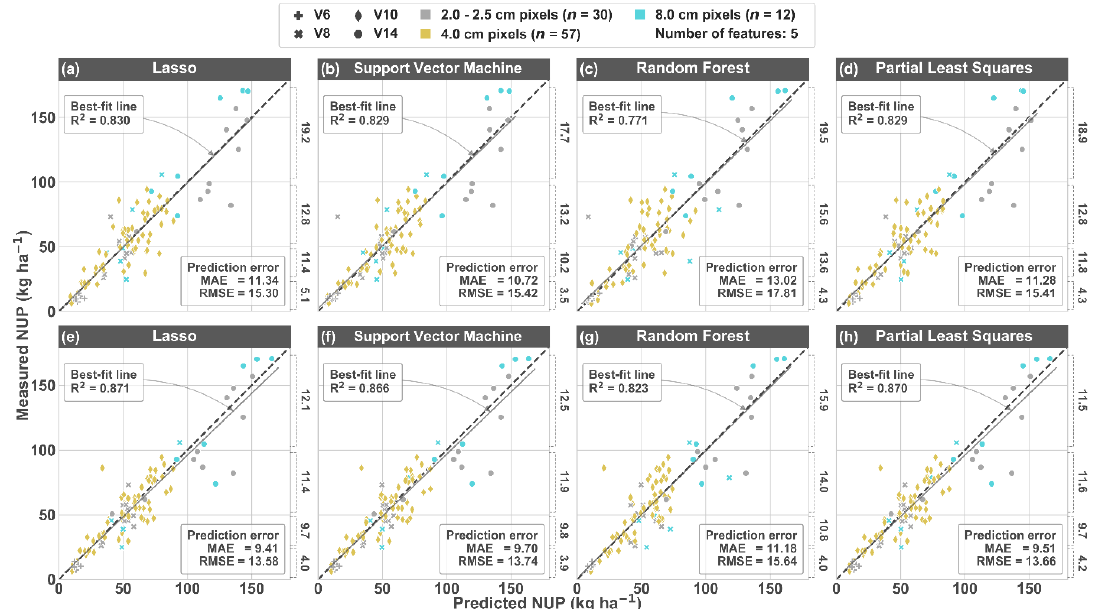
Figure 7. Measured and predicted nitrogen uptake (NUP) values from each of the four learning models using the test dataset ( n = 99). Plots in the top row ( a – d ) used five spectral features (739, 741, 801, 867, and 873 nm), and plots in the bottom row ( e – h ) used four spectral features (737, 739, 867, and 871 nm) in addition to the 10th percentile MCARI2 (Modified Chlorophyll Absorption Ratio Index Improved) before image segmentation. The mean absolute error (MAE) and root mean squared error (RMSE) correspond to the prediction error (i.e., deviation from the 1:1 dashed line), whereas the coe ffi cient of determination (R 2 ) corresponds to the best-fit line. MAE values stratified by measured NUP are shown along the right axis of each plot (“very low”, “low”, “medium”, and “high” groups are stratified as: NUP < 25 kg ha − 1 ; 25 ≥ NUP < 50 kg ha − 1 ; 50 ≥ NUP < 100 kg ha − 1 ; and NUP ≥ 100 kg ha − 1 , respectively).